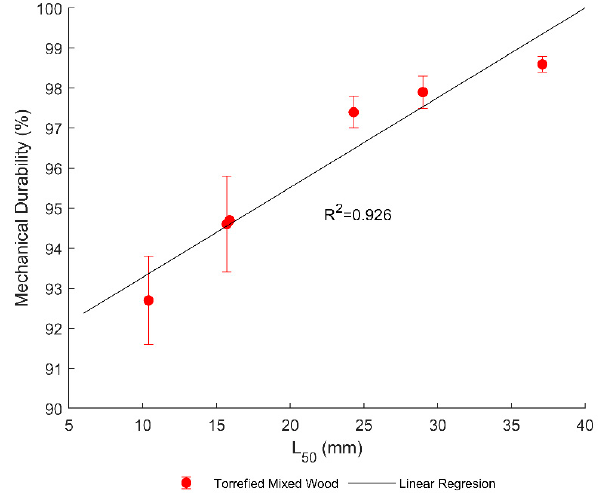
Figure 8. Mechanical durability values of torrefied mixed wood pellets versus the L 50 of various length distributions. Error bars show the standard deviation.